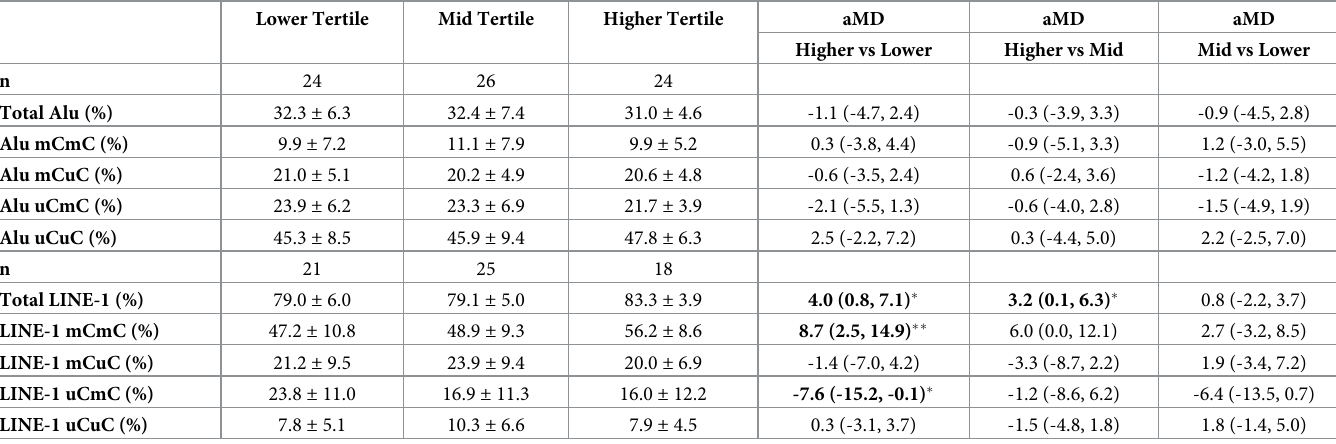
Table 8. DNA methylation levels in young adult offspring according to tertiles of maternal plasma zinc concentrations in late pregnancy. Lower Tertile Mid Tertile Higher Tertile